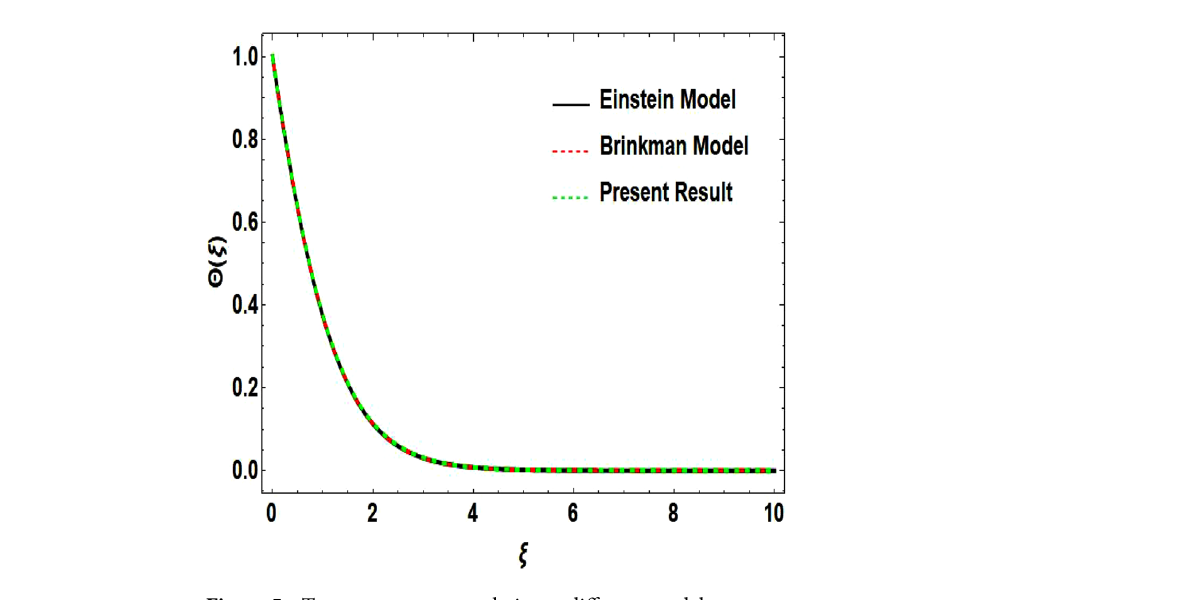
Figure 5. Temperature curve relative to different